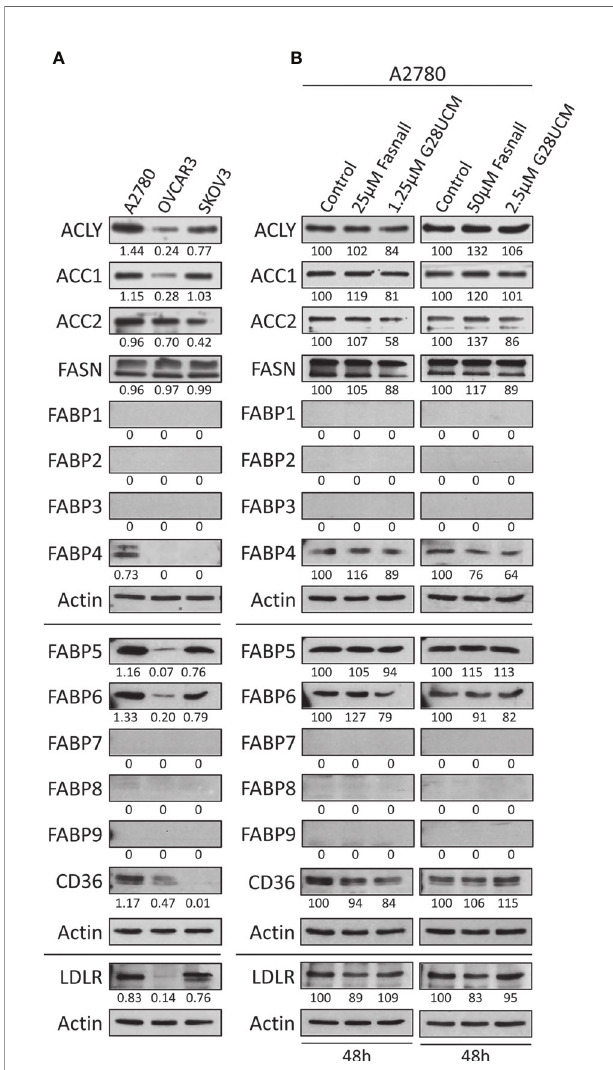
FIGURE 2 | Expression of lipid metabolic proteins in OC cell lines as determined by Western blotting. (A) Baseline levels of the lipogenic enzymes ATP-citrate lyase (ACLY), acetyl-CoA carboxylase 1 (ACC1), ACC2 and FASN, the lipid transport proteins FABP1 – FABP9, and the lipid receptor proteins CD36 and LDLR in A2780, OVCAR3 and SKOV3 OC cell lines. A2780 cells were found to express the widest range of these lipid metabolic proteins. (B) Inhibition of FA synthesis by the FASN inhibitors G28UCM or Fasnall does not affect the expression of the lipid metabolic proteins in A2780 OC cells. Blots were (co-)probed for several proteins of interest and re- probed for actin as loading control. Previous antibodies were stripped from the membranes before detection of ACLY, ACC1 and ACC2. The band intensities were determined using ImageJ software, and in A the ratios between the proteins of interest and the corresponding actin are given under each autoradiograph, whereas in B these ratios were normalized to the untreated control samples (100%) and are expressed in percent of control. Experiments were repeated at least